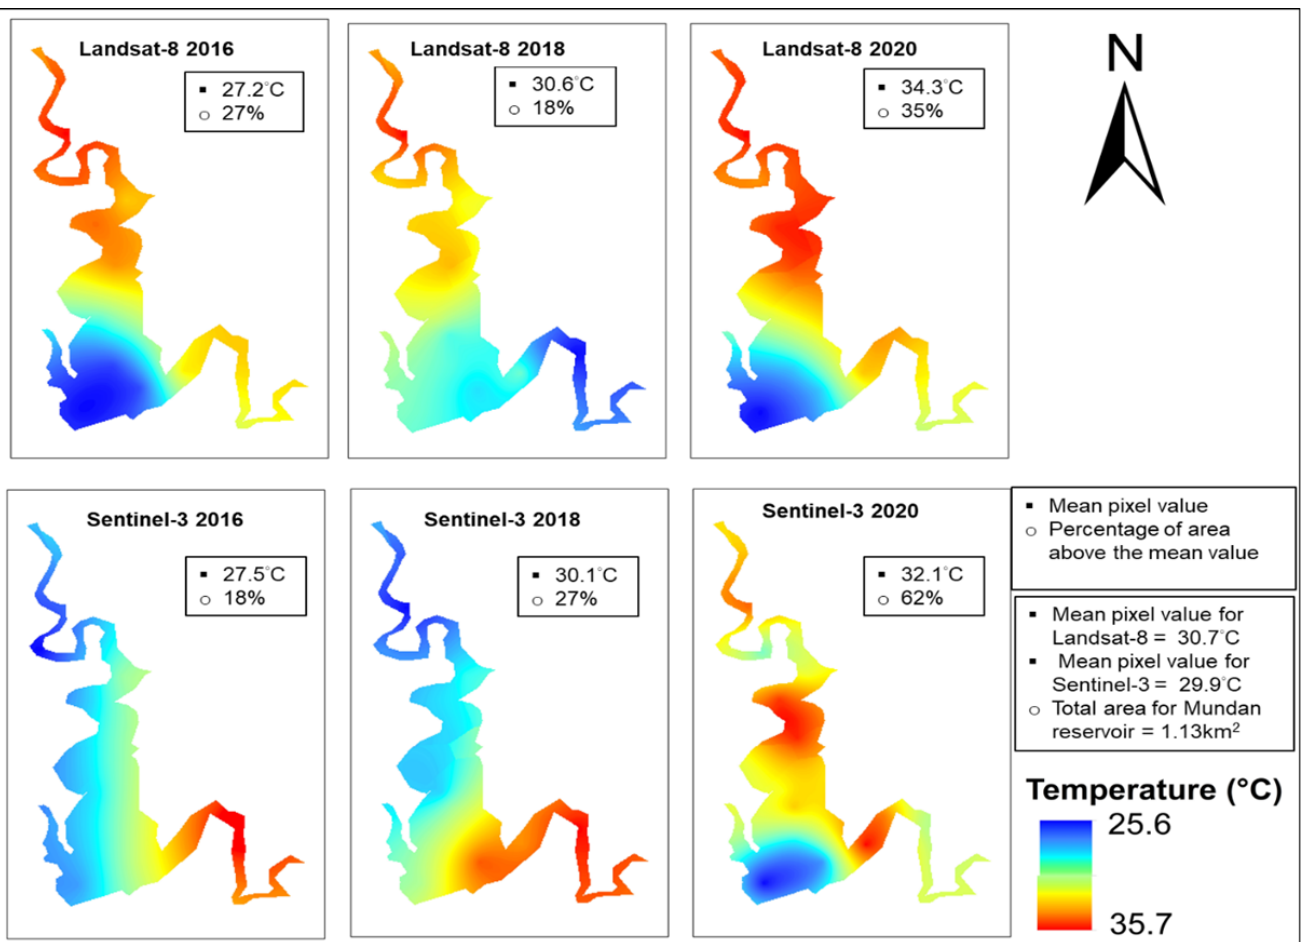
Figure 12. Time series for the spatial distribution of SWT based on ConvLSTM predictions smoothened by Kriging interpolation in Mundan water reservoir.